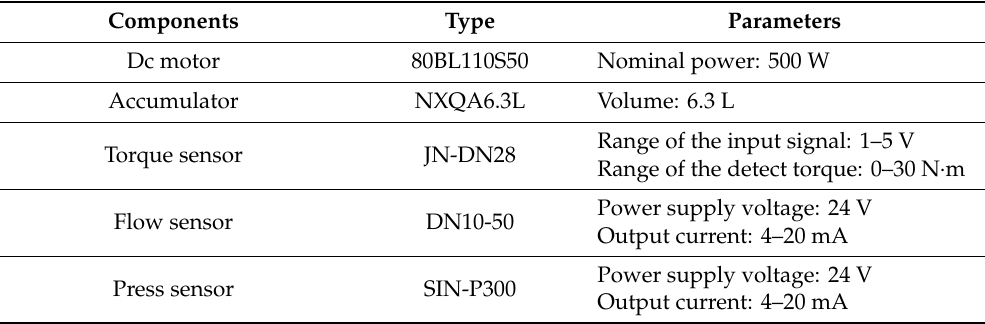
Figure 5. Wind-motor hybrid power pumping unit model.